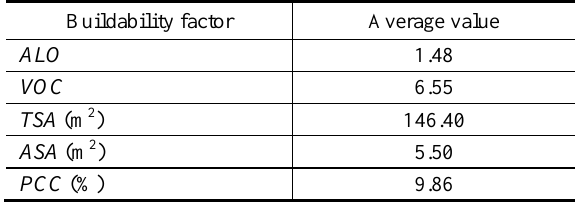
Table 5. Regression coefficients statistics for